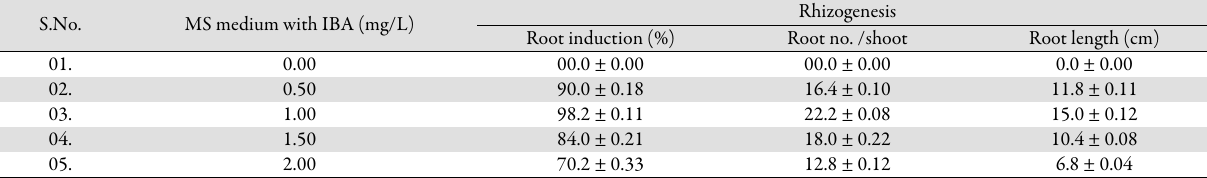
Table 3. In vitro rhizogenesis of Physalis angulata L. microshoots